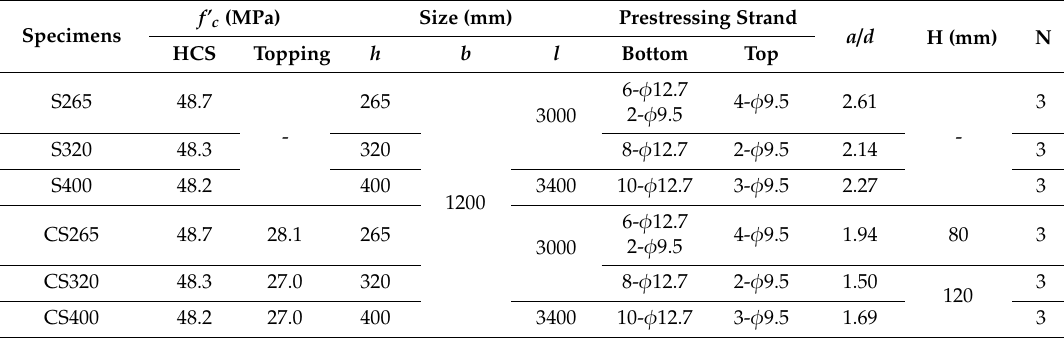
Figure 2. Stress-strain relationships of concrete. Table 2. Properties of specimens.